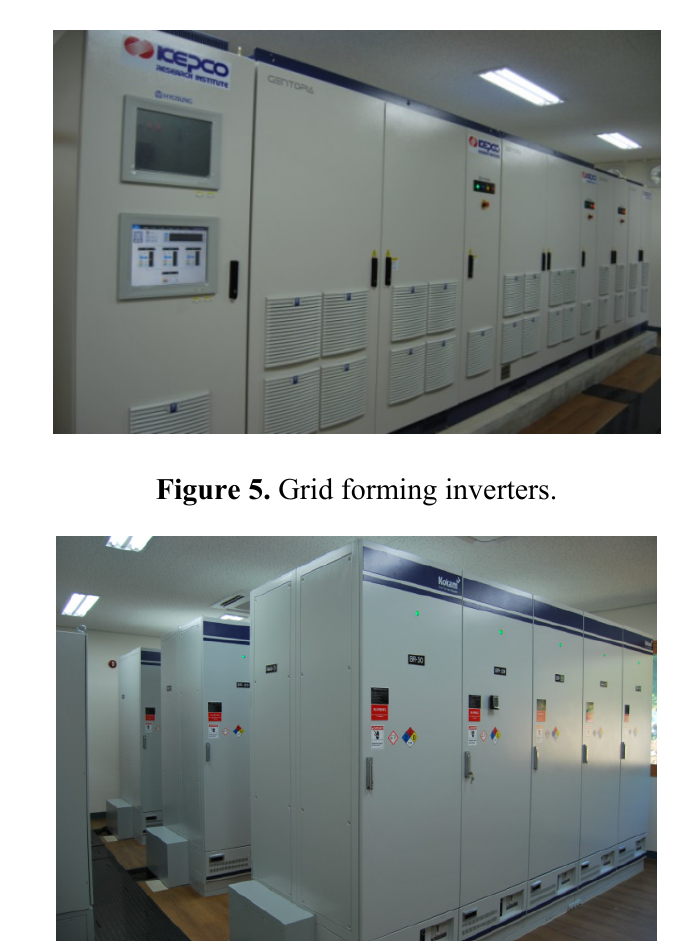
Figure 4. Wind and solar farm.